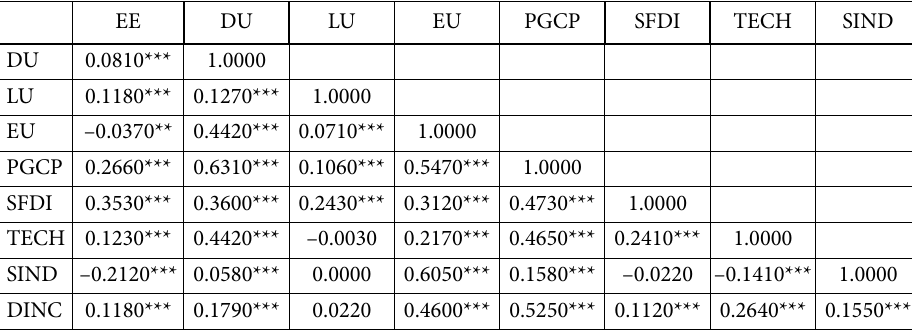
Table 2. Correlation coefficients among independent